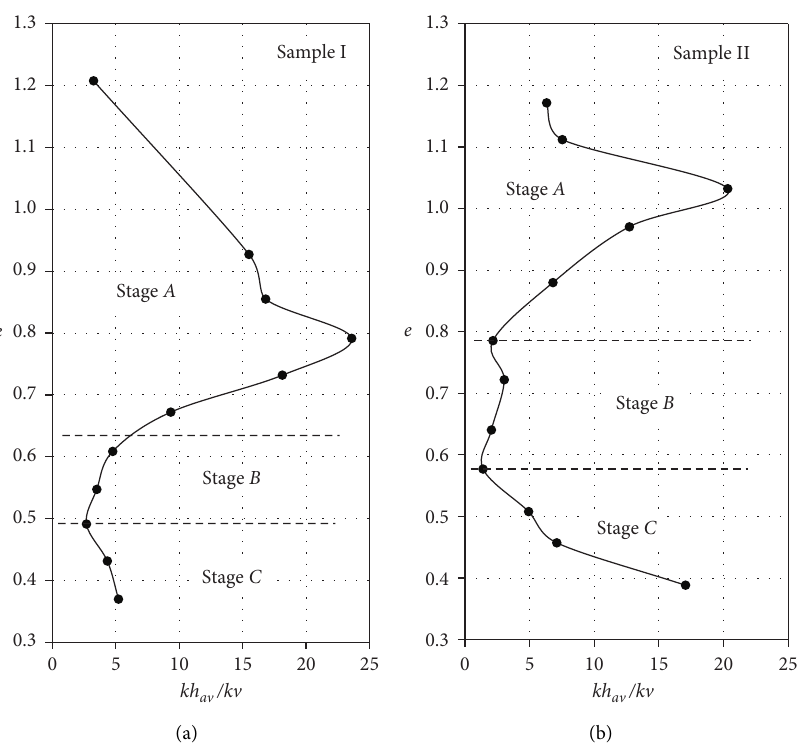
Figure 6: Anisotropic permeability variations of samples during the static